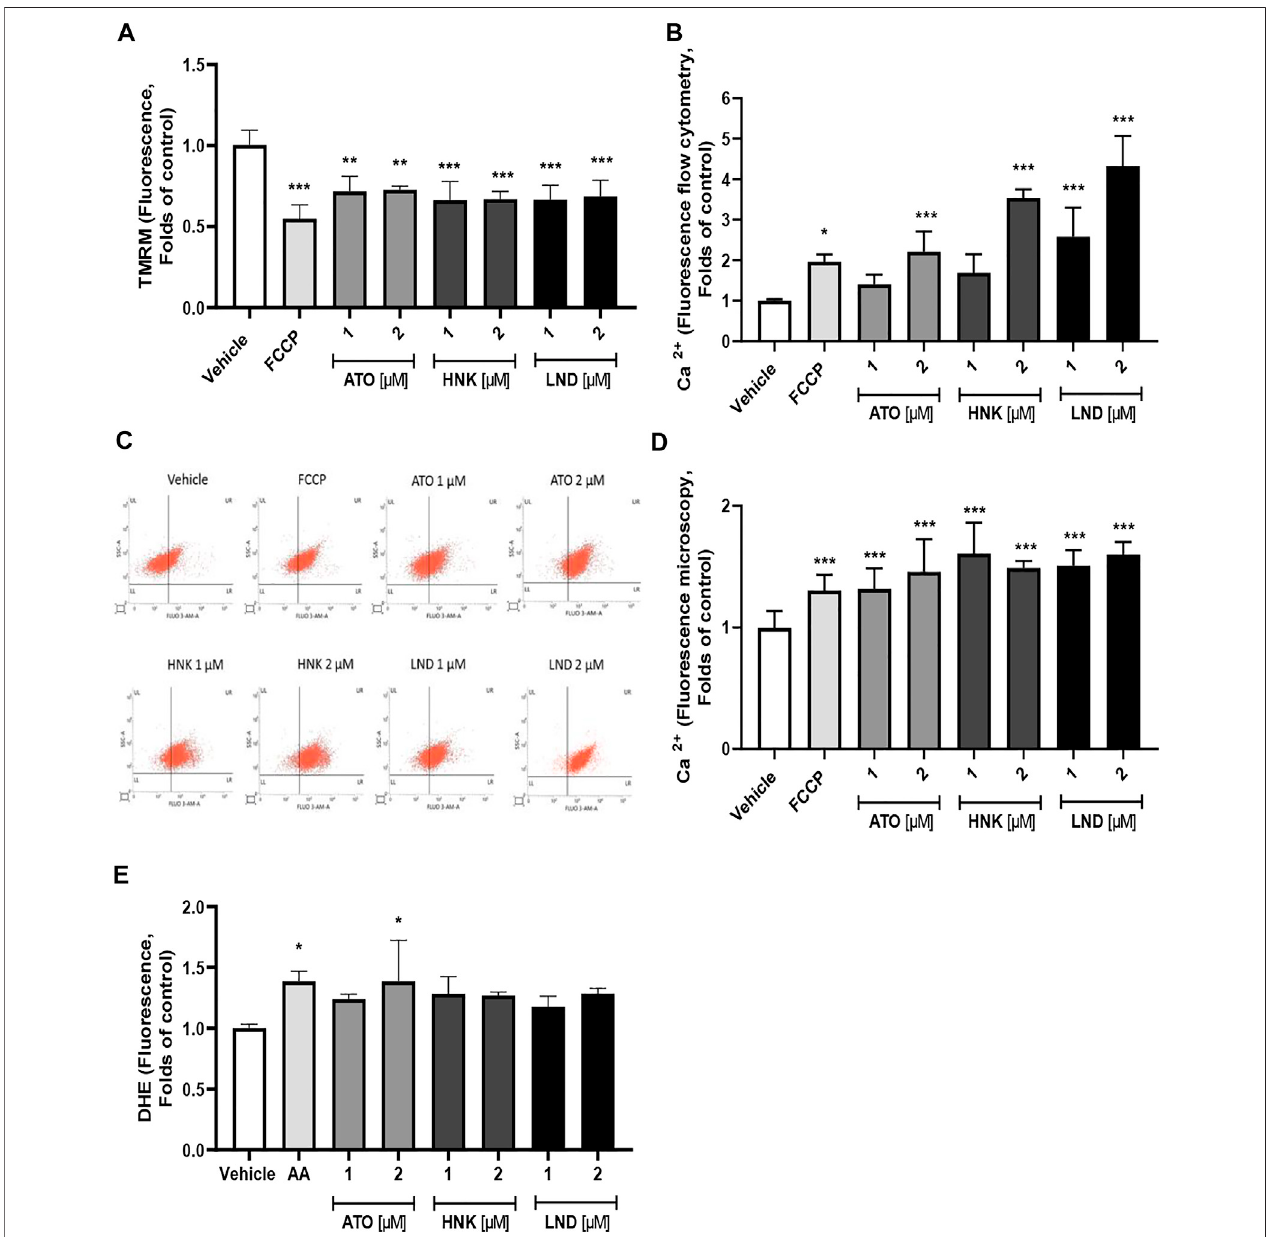
FIGURE 3 | Effect of the compounds on the (A) mitochondrial membrane potential ( Δ Ψ m), (B – D) intraplatelet calcium levels, and (E) intraplatelet ROS levels. The resultswereobtainedby (B,C) fl owcytometryand (D) fl uorescencemicroscopy. (B) Representativedotplotsfrom fl owcytometryofintraplateletcalciumlevels.Platelets wereidenti fi edasCD61 + populationandtheseCD61expressionswereanalyzedintermsofchangeinthemean fl uorescenceintensityfromthevehicle.FCCPwasused as a positive control of mitochondrial depolarization; AA was used as a positive control of ROS induction. The results were expressed as mean ± SEM. Vehicle: DMSO 0.4%. The statistical analysis was performed using a one-way analysis of variance (ANOVA) and the Bonferroni post hoc test. p p < 0.05; pp p < 0.01, and ppp p < 0.001 vs.